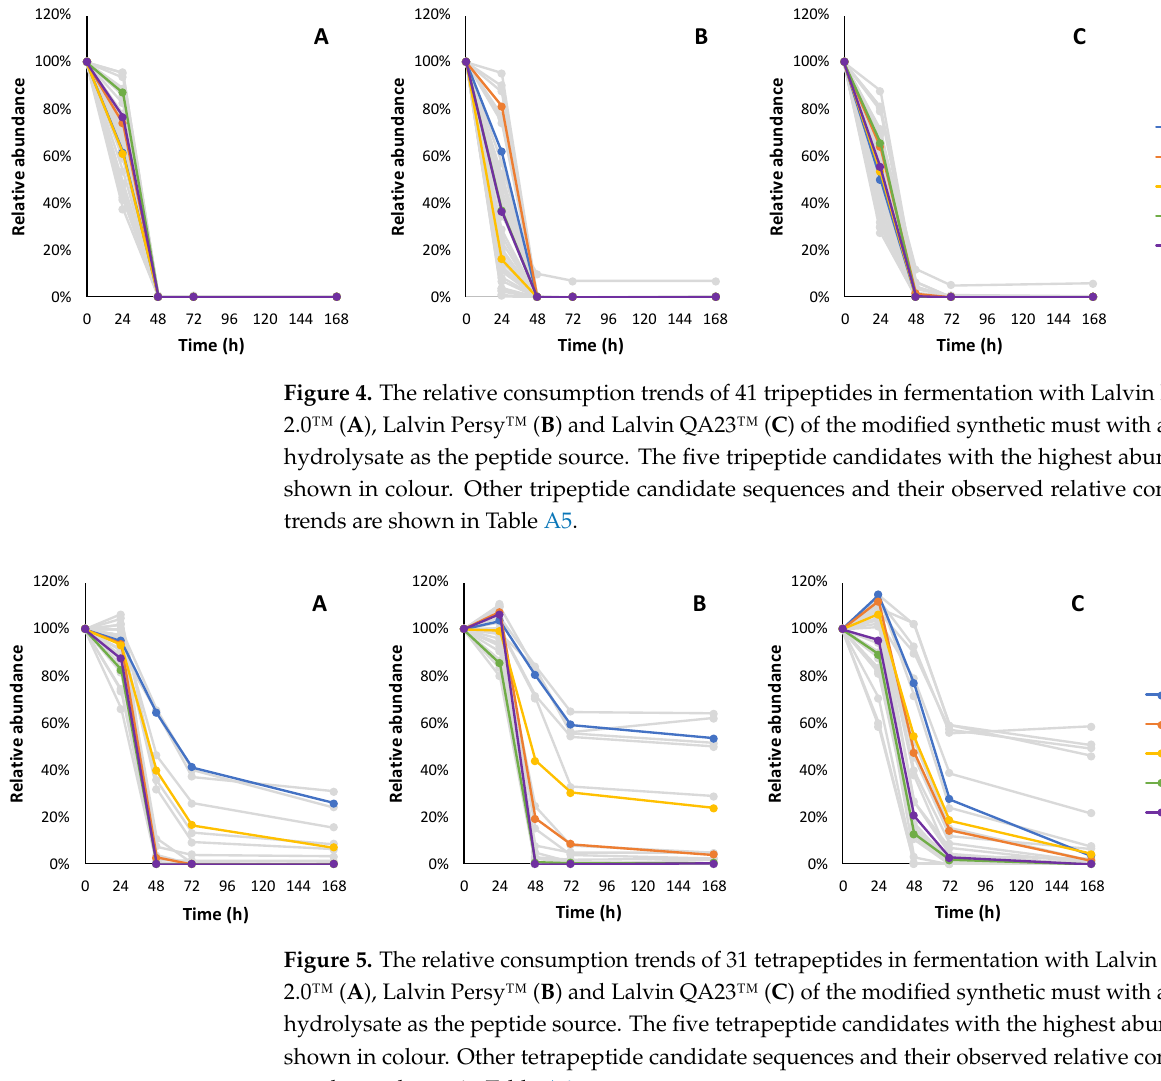
Figure 3. The relative consumption trends of 19 dipeptides in fermentation with Lalvin ICV Opale 2.0™ ( A ), Lalvin Persy™ ( B ) and Lalvin QA23™ ( C ) of the modified synthetic must with added BSA hydrolysate as the peptide source. The five dipeptide candidates with the highest abundance are shown in colour. Other dipeptide candidate sequences and their observed relative consumption trends are shown in Table A4.